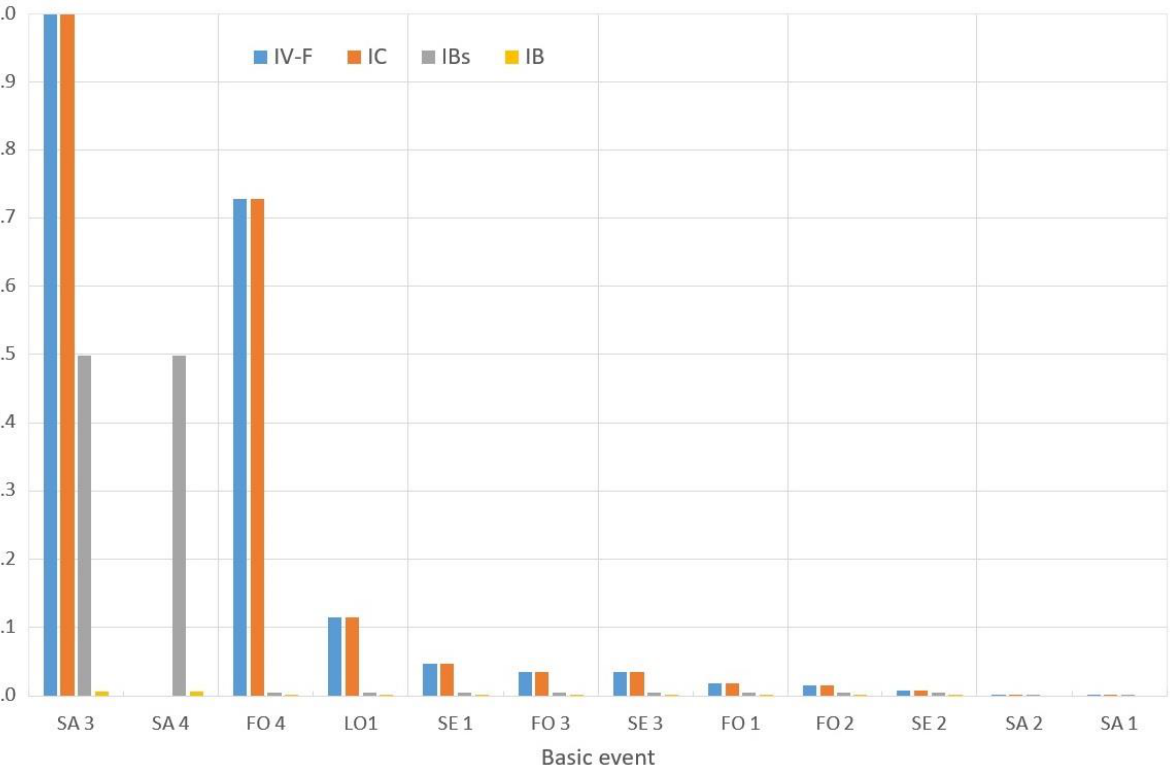
Figure 8. Analysis of the importance of the individual basic events.